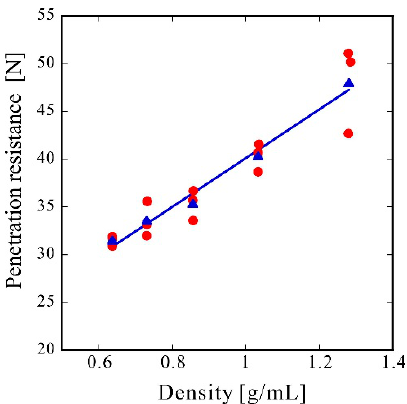
Figure 2. Penetration resistance. Experimental results ( red circle ) and averages of three experimental data points ( blue triangle ) at each bulk density and the linear fitting result ( blue solid line ).